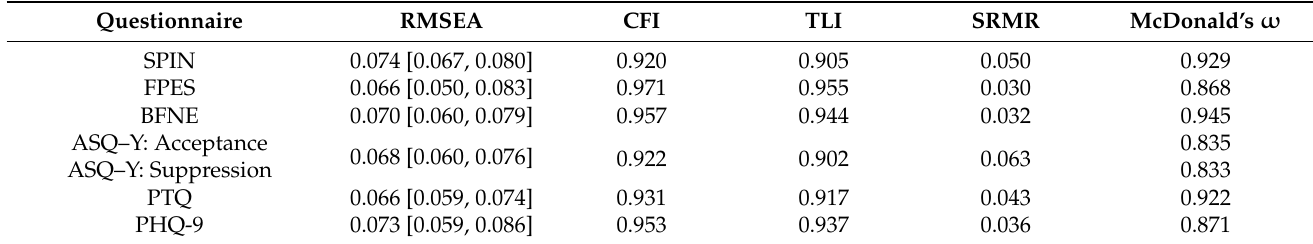
Table 3. Confirmatory factor analyses: model fit indices and composite